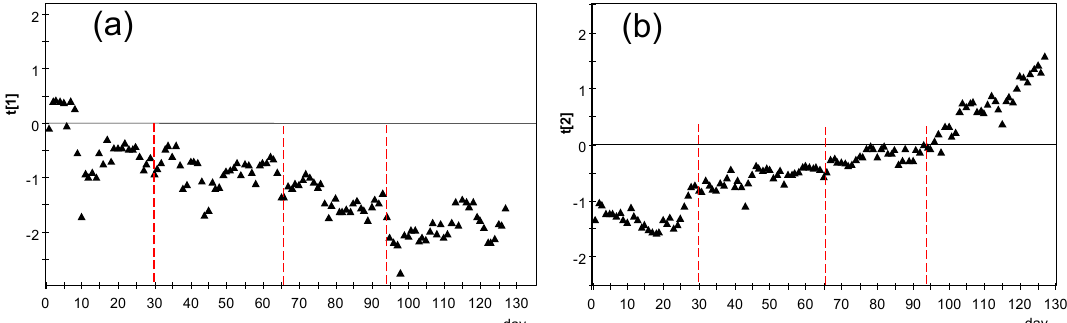
Figure 16. Results from the PCA applied to the matrix of daily medians for the period of 130 days: ( a ) evolution of scores corresponding to PC1, ( b ) evolution of scores corresponding to PC2.